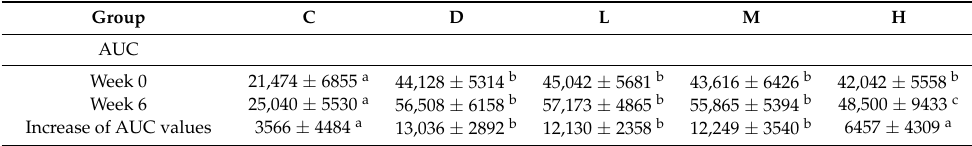
Figure 1. Oral glucose tolerance test (OGTT): ( A ) before; and ( B ) after the six-week melatonin intervention. All values are the mean ± SD ( n = 8). * p < 0.05 compared to the diabetic group. # p < 0.05 compared to the diabetic group. C, control group; D, diabetic group; L, low-dosage group (10 mg melatonin/kg of body weight (BW)); M, medium-dosage group (20 mg melatonin/kg of BW); and H, high-dosage group (50 mg melatonin/kg of BW). Table 4. Glucose tolerance before and after the six ‐ week melatonin intervention.